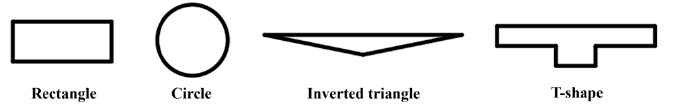
Figure 13. Schematic diagram of different section shapes of the guidance track.